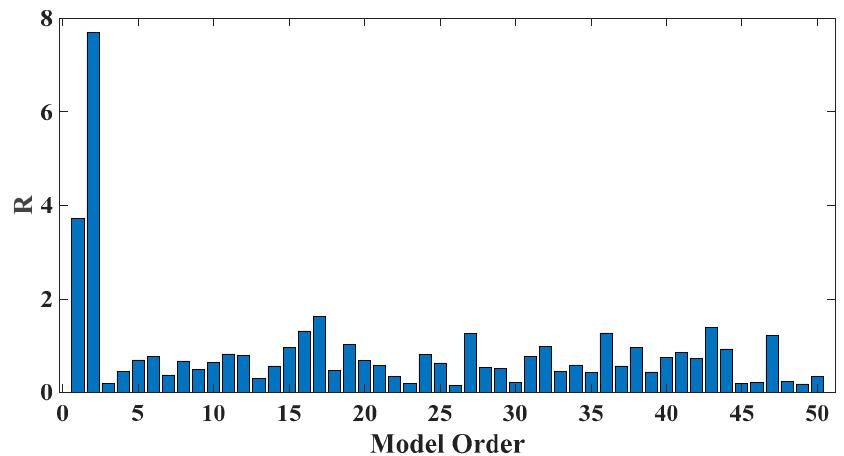
Figure 30. AIC of an AR model for the third floor response under the case of removing central columns on the third floor.